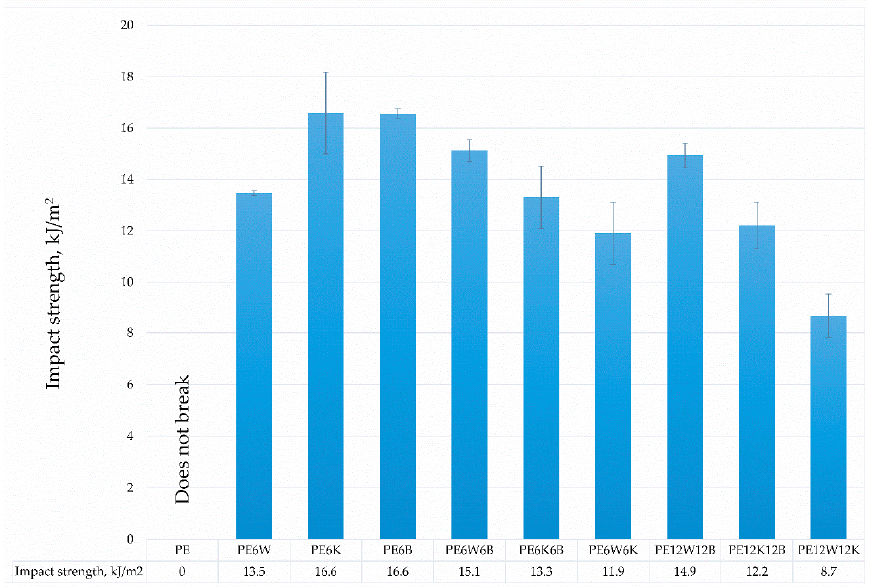
Figure 4. Comparison of impact strength.